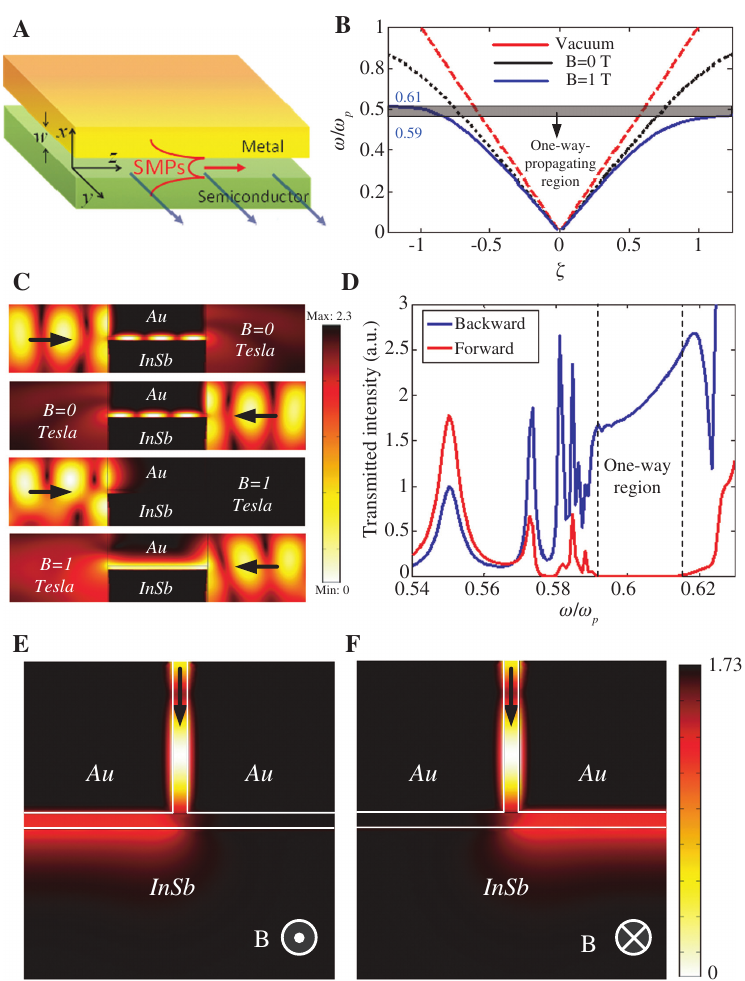
Figure 9: A one-way infrared (IR) waveguide based on the nonreciprocal effect of SMPs (from [77]). (A) Schematic structure of the one-way THz plasmonic waveguide. It is composed of metal (upper), dielectric (middle), and semiconductor (lower) layers. (B) Dispersion relations of the THz SMPs without and with an external magnetic field. (C) FEM-simulated field distribution of the forward and backward propagating waves in a sub-wavelength slit. The width and length of the slit are 0.1 × 2 π c / ω and 300 μ m, respectively. The incident frequency is ω = 0.6 p ω , which is in the one-way frequency band. (D) Transmitted intensities of the forward and backward propagating waves when 1 Tesla mag- p netic field is applied. (E) and (F): Field distributions of a designed THz plasmonic switch when the magnetic field is along + y -axis and along - y -axis,